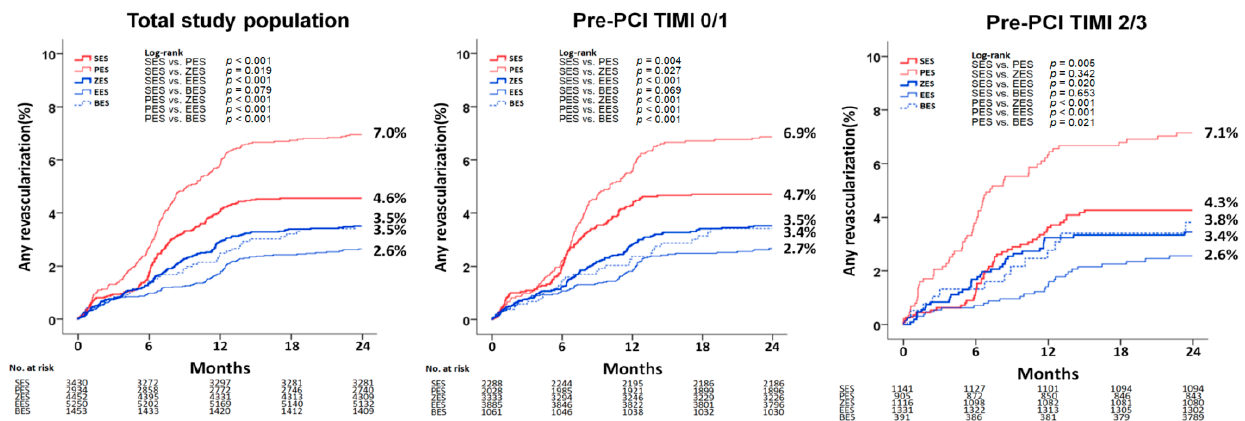
Figure 3. Kaplan–Meier analysis of any repeat revascularization according to the kinds of deployed stents. SES, serolimus- eluting stent; PES, paclitaxel-eluting stent; ZES, zotarolimus-eluting stent; EES, everolimus-eluting stent; BES, biolimus- eluting stent; Pre-PCI, pre-percutaneous coronary intervention; TIMI, thrombolysis in myocardial